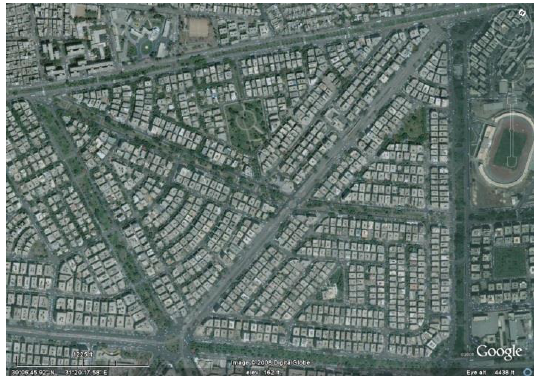
Figure 3. Satellite image for a neighborhood scale of about 1 km 2 of Misr Al-Gadida, case no.2 (urban).